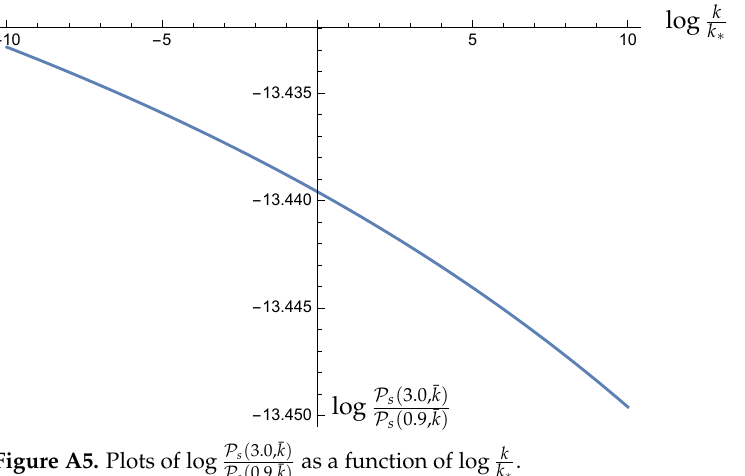
,¯ k ) with ¯ k = e − 60 (blue), e − 50 (yellow) and e − 40 (green). P s ( 0.9,¯ k )